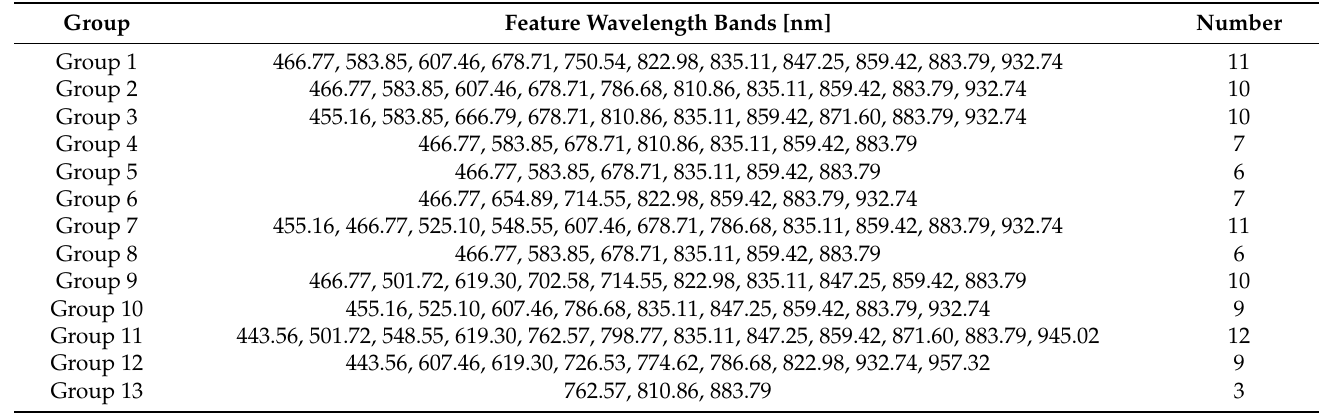
Table 3. The results of feature wavelength bands selected using FD data under different adulteration groups.